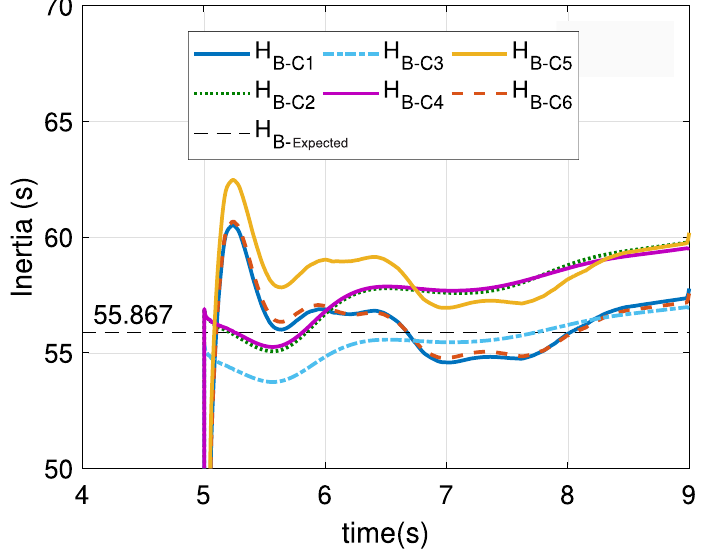
Figure 16. Inertia estimated–Study 1–Area